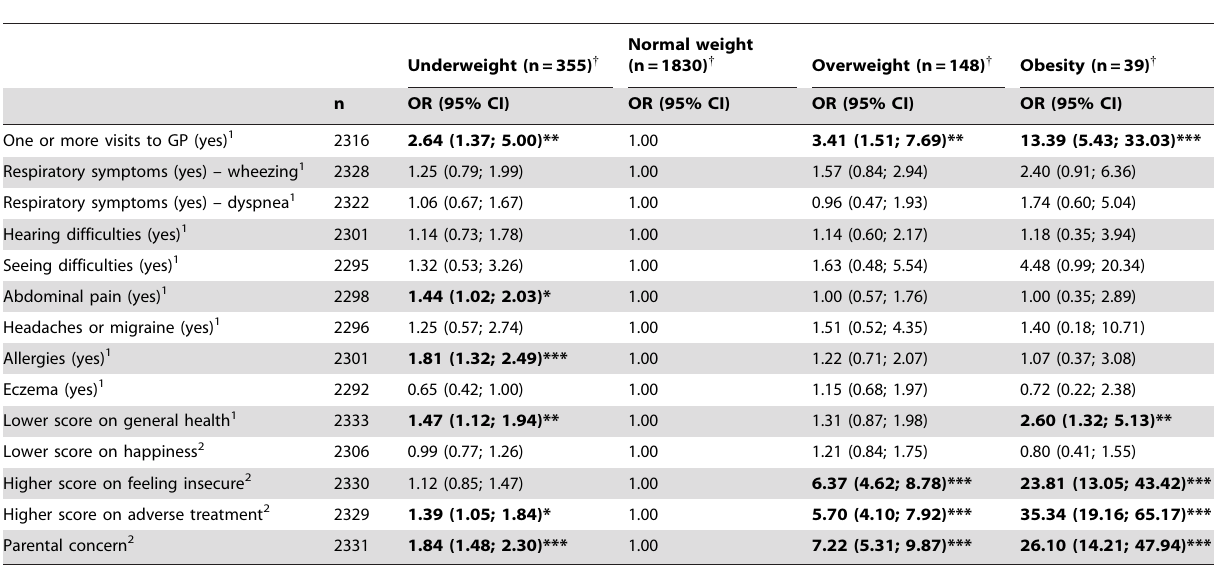
Table 3. Health outcomes at age 7 years, predicted by BMI status at age 5 years.